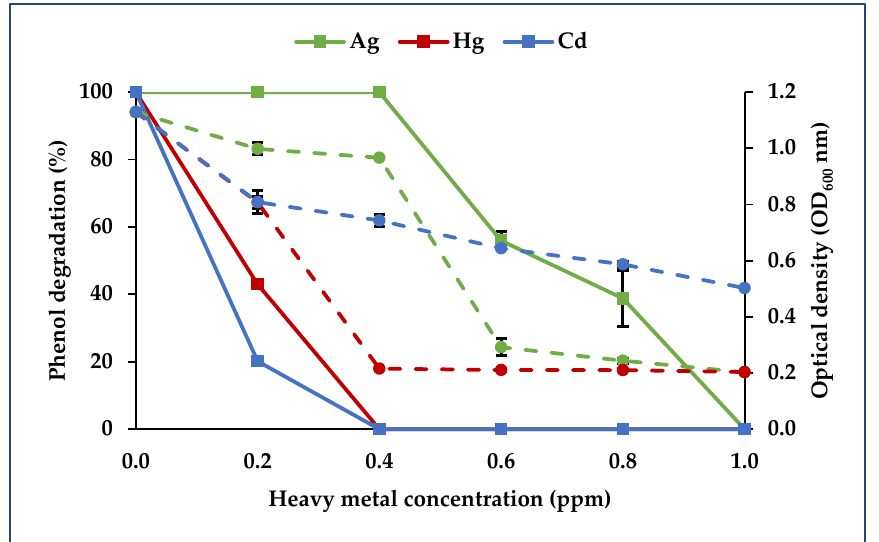
Figure 8. Effects of different concentrations of Ag, Hg, and Cd on phenol degradation (solid line) and growth (dotted line) of Arthrobacter sp. strain AQ5-15. Error bars represent the mean ± standard deviation of three replicates.